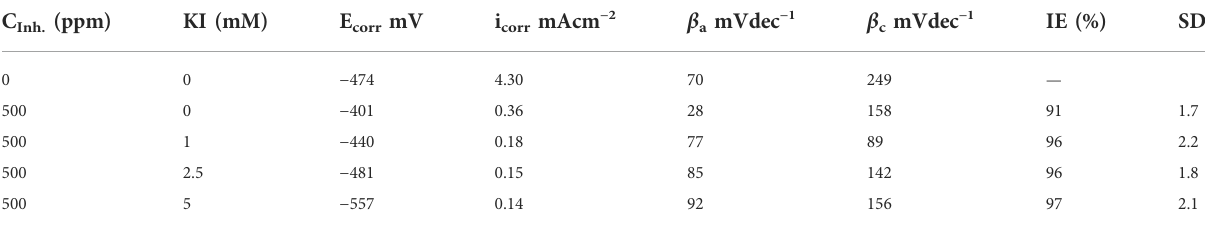
TABLE 4 Electrochemical parameters obtained from the polarization curves for corrosion inhibition of 1018 steel in acid media with 500 ppm of M. sativa and different KI concentrations at 40 ° C. C (ppm) Inh.